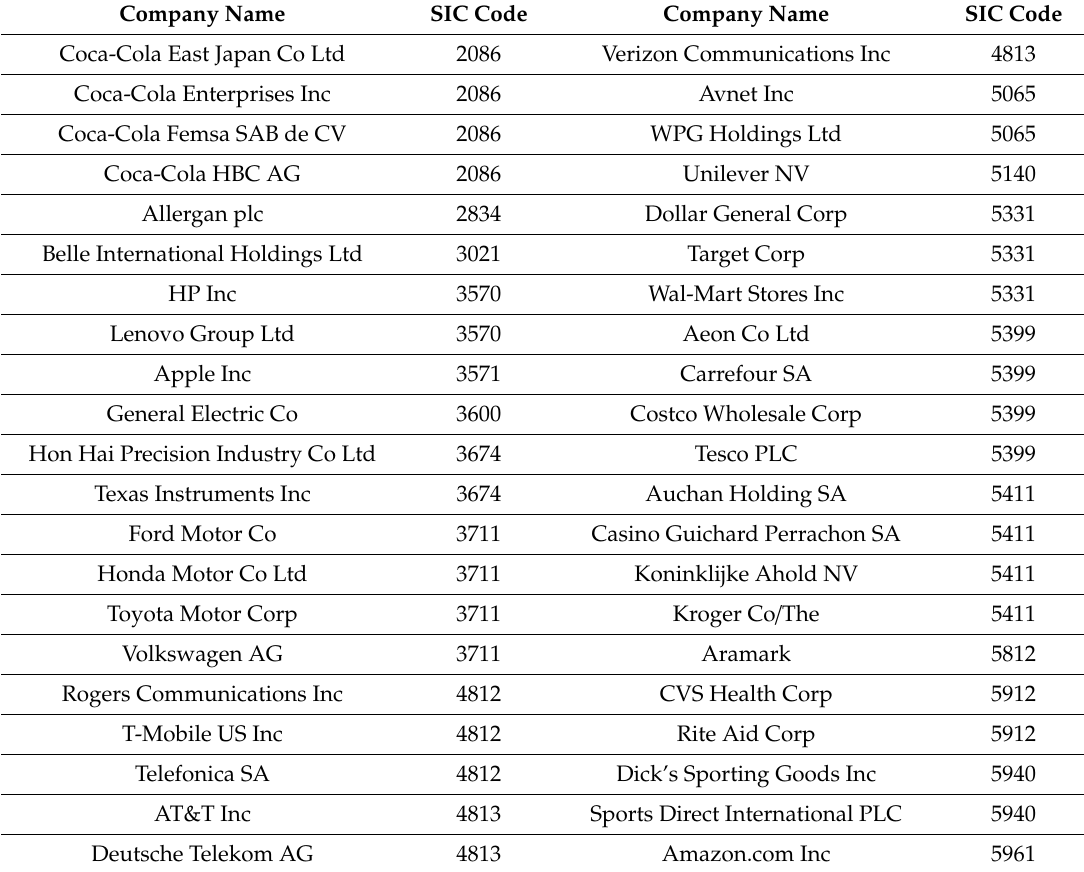
Table A3. Customer firms and four-digit SIC codes (after